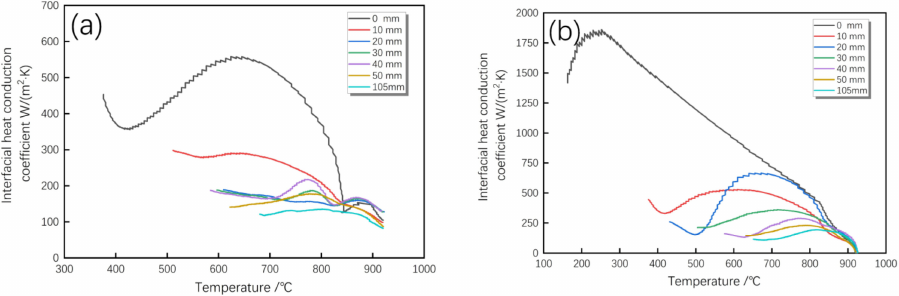
Figure 16. Interfacial heat conduction coefficient. ( a ) 0.1 MPa compressed air; ( b ) 0.5 MPa compressed air mixed with dry ice particles.